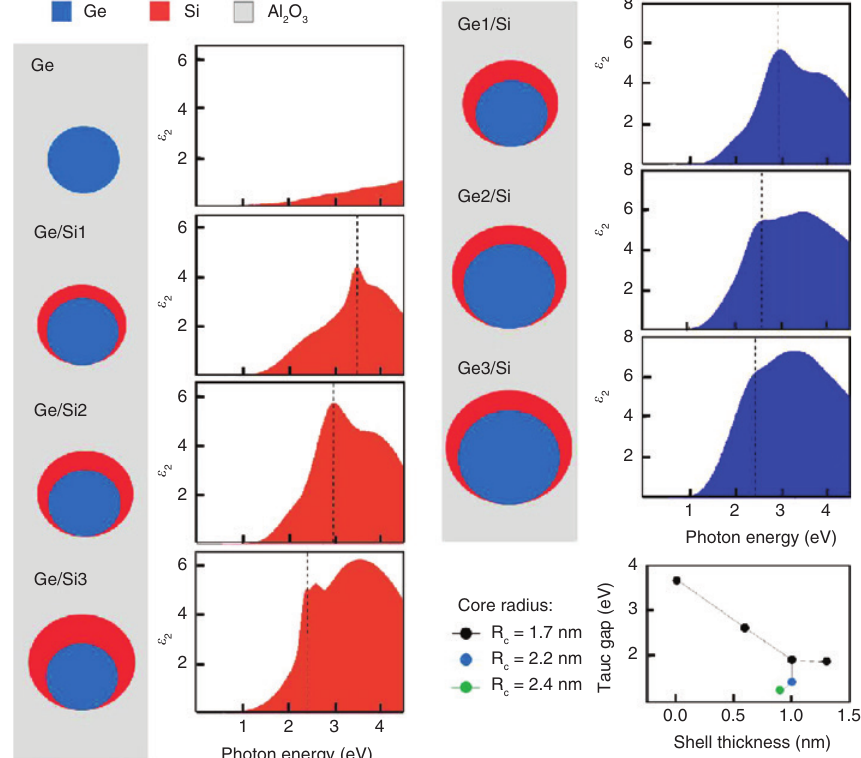
Figure 6: Tuning the optical properties (imaginary part of the dielectric function) by changing the shell thickness (red) and core size (blue). Pure Ge QDs have a lower absorption than Ge/Si QDs. The last image represents the Tauc gap depending on the shell thickness (black dots) and core size (blue and green